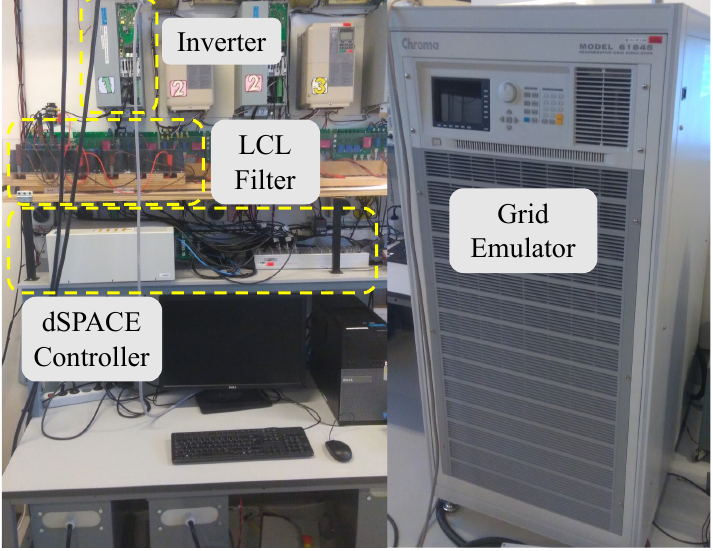
Figure 10. Experimental setup where the controller is based on